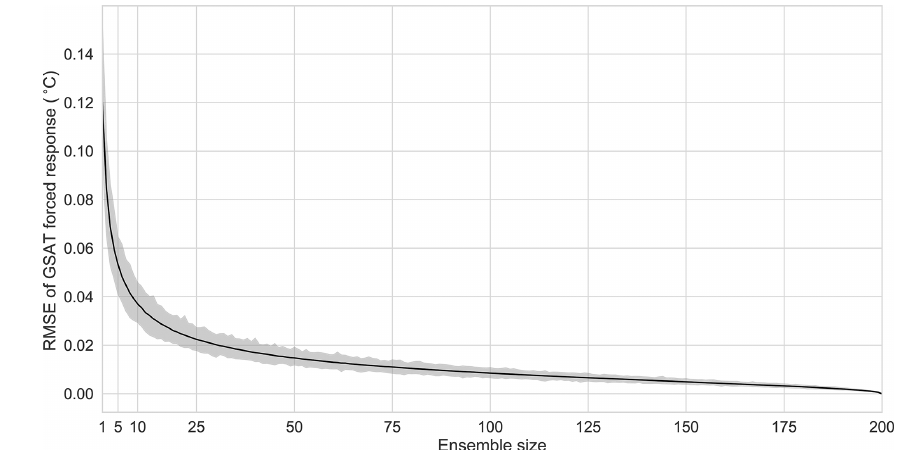
Figure 2. A larger ensemble allows a more accurate quantification of the forced response. The black line shows the mean RMSE for GSAT for ensemble sizes from 2 to 200. The reference is the 200-member mean from Fig. 1, and the RMSE is computed for all 1000 samples. The shaded area shows the range of RMSE values for individual samples; the solid line shows the mean